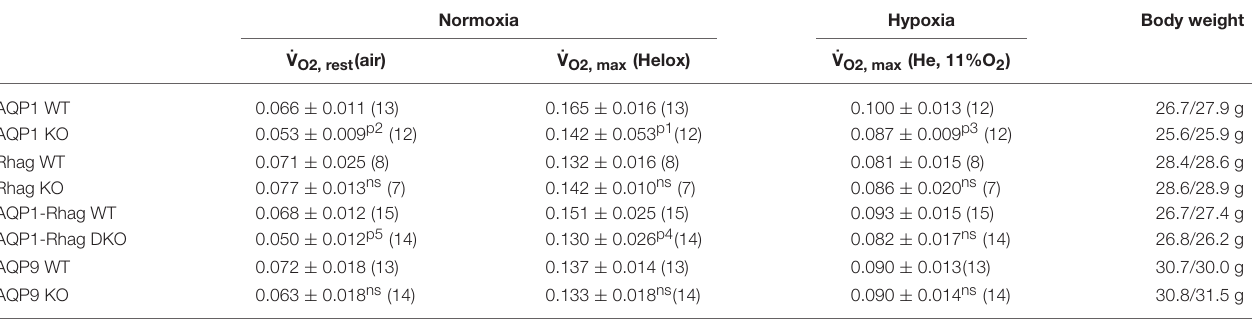
TABLE 1 | Results of ˙V O2 measurements in KO and WT mice (in ml O 2 /g/min).